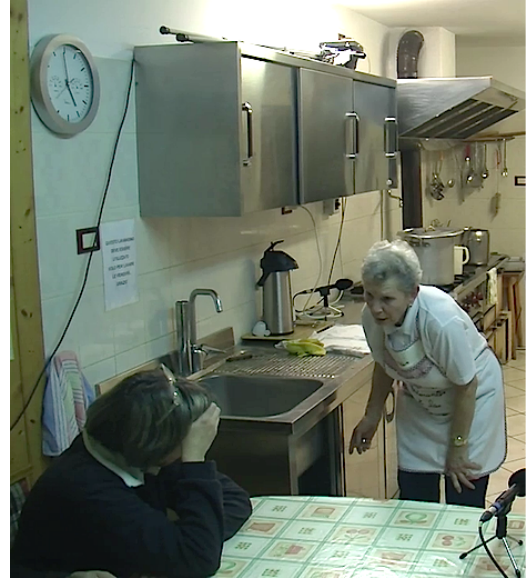
Figure 1: Extract (3) lines 1-2. Piera rummages in a kitchen cabinet while Loretta asks her 'it expires tomorrow right?'.